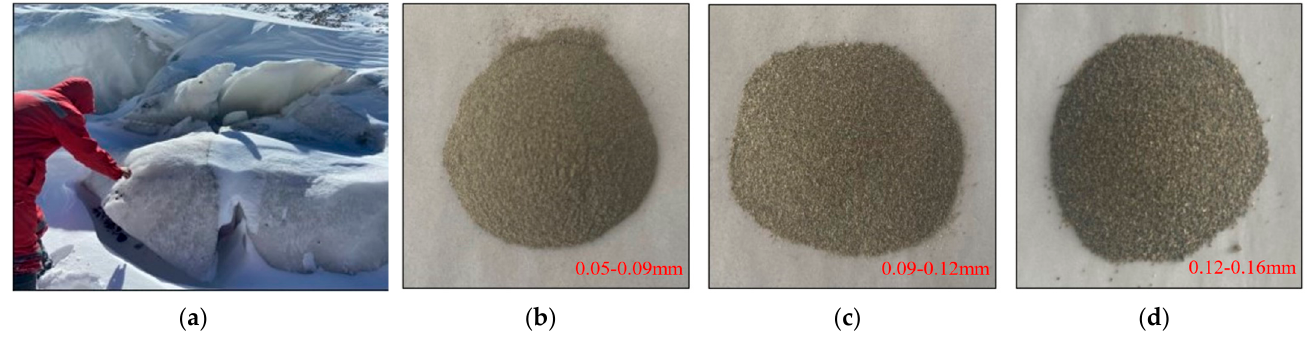
Figure 4. ( a ) Dust collected at the glacier site in the study area. ( b ) Dust with particle size of 0.05–0.09 mm. ( c ) Dust with particle size of 0.09–0.12 mm. ( d ) Dust with particle size of 0.12–0.16 mm. Table 1. Mineral dust particle size gradation.